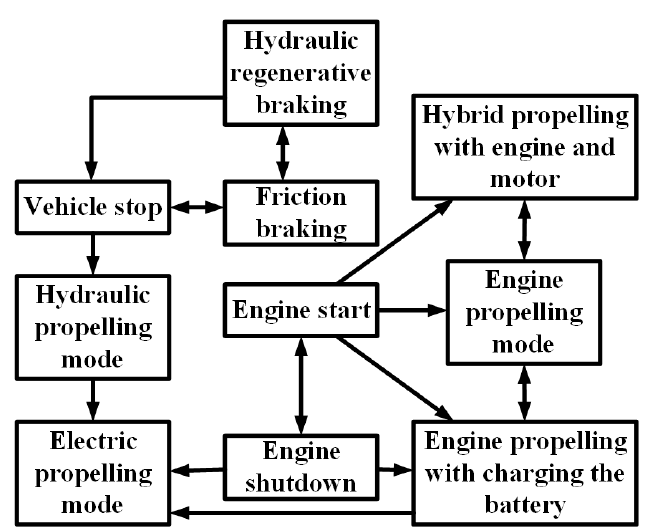
Figure 70. Working principle of the SOC measuring algorithm proposed by Zhou et al. [180].